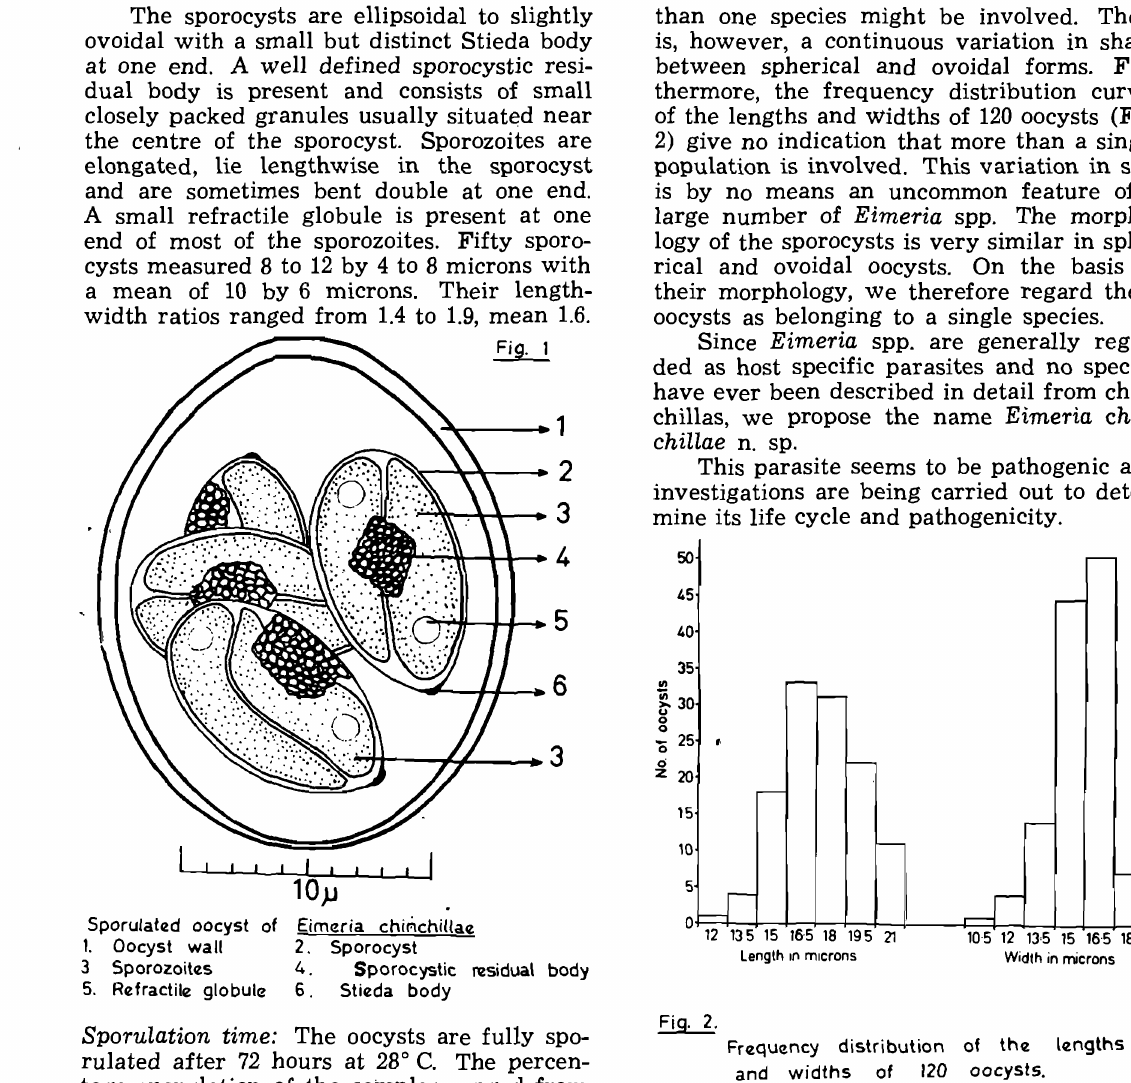
Sporulation time: The oocysts are fully spo rulated after 72 hours at 28° C. The percen tage sporulation of the samples ranged from 65 to 89 per